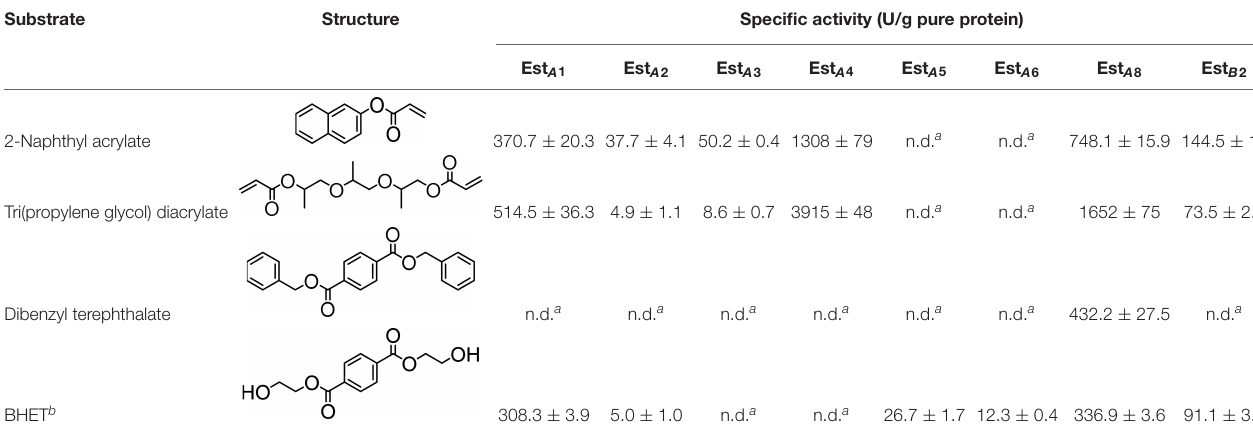
TABLE 3 | Specific activity (U/g pure protein) for each of the enzymes able to hydrolyze a set of structurally different plastic-related esters. Substrate